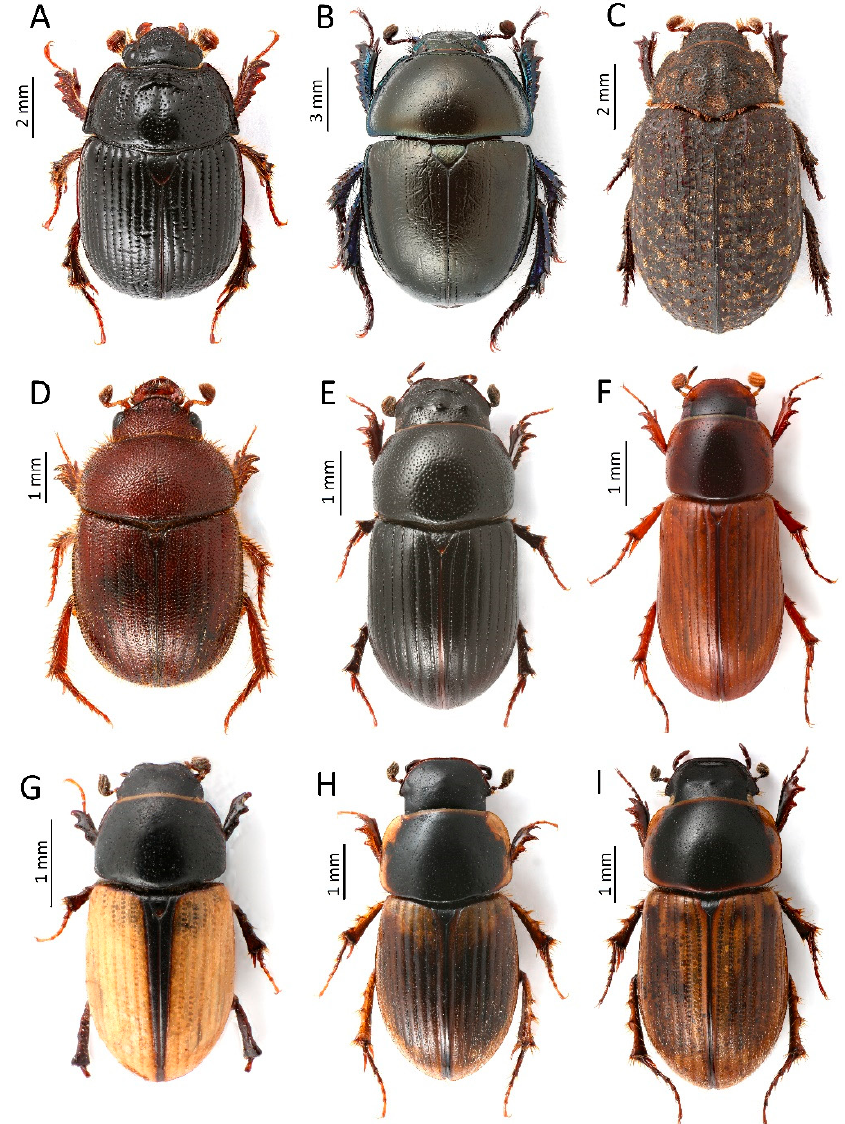
Figure 5. Rare and new species for the fauna of Montenegro were recorded in the course of this